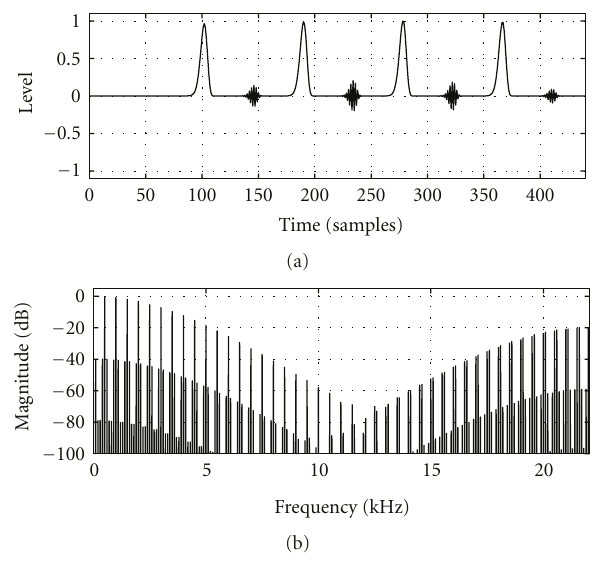
Figure 8: FBAM spectrum and waveform with β = 1 . 9 ( f 0 =